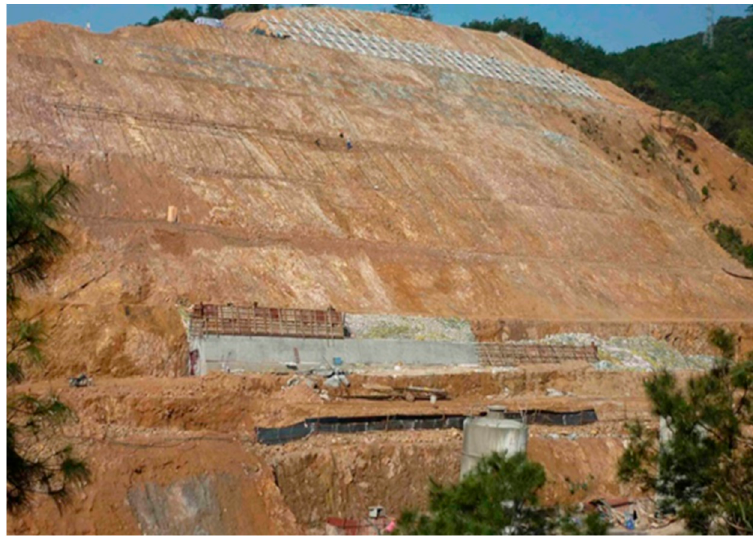
Figure 2. The high cutting slope of section DK592 + 532.00~ + 562.00.